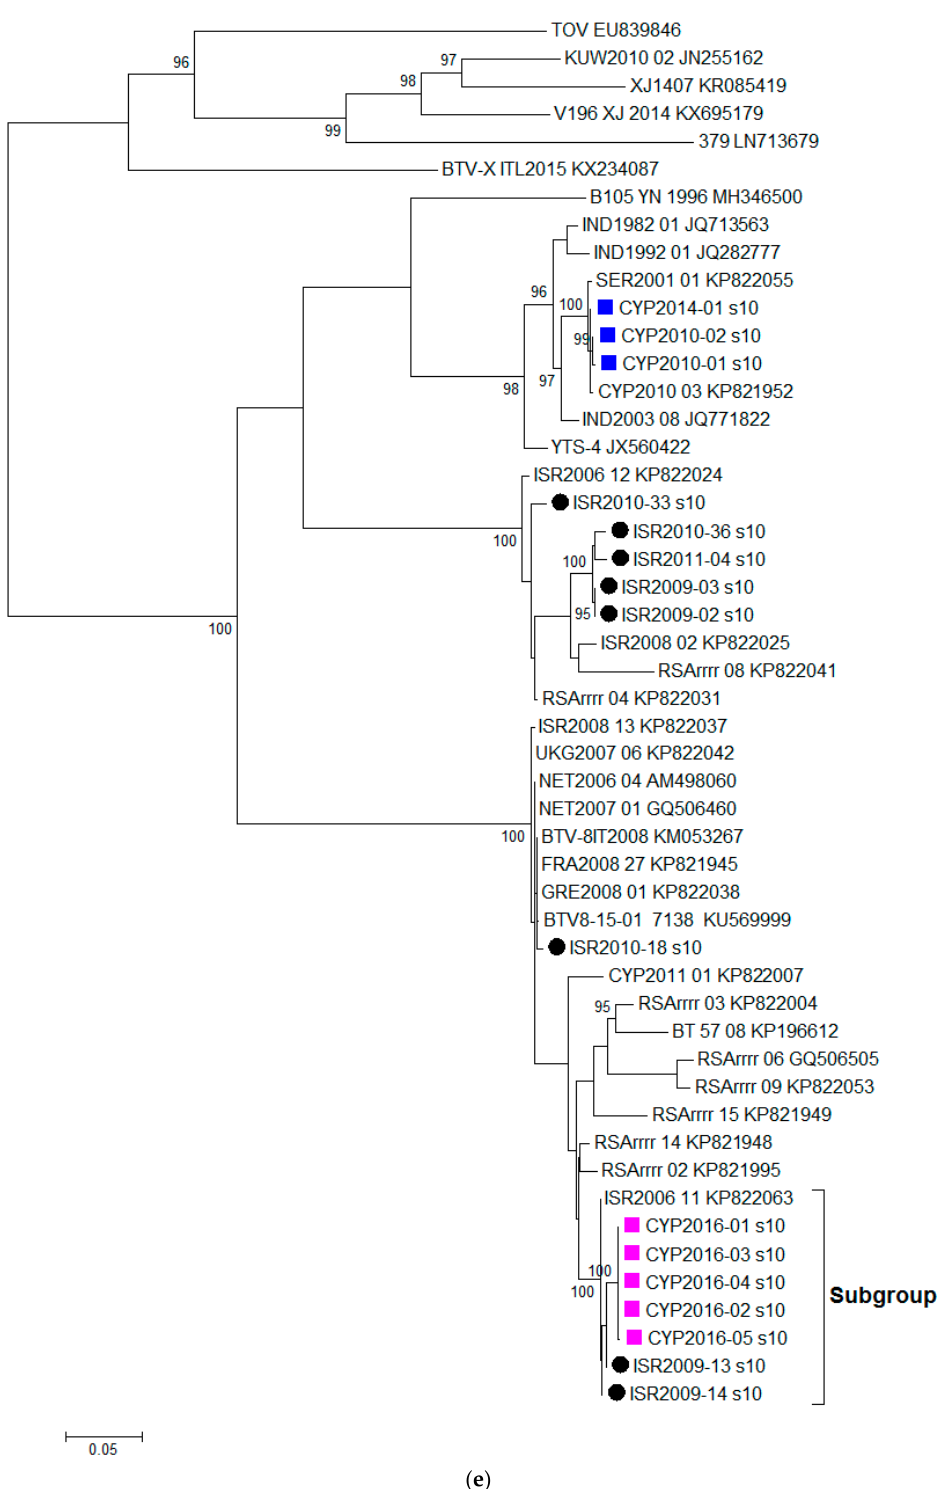
Figure 1. Phylogenetic trees were constructed for the coding regions of BTV: ( a ) VP2 protein (Segment 2); ( b ) VP4 protein (Segment 4); ( c ) VP7 protein (Segment 7); ( d ) VP6 protein (Segment 9); and ( e ) NS3 protein (Segment 10). Maximum likelihood trees were constructed using IQ-Tree software [25] and the reliability of each tree was estimated by ultrafast bootstrap [26] analysis of 1000 replicates (bootstrap values of < 95% are not displayed).